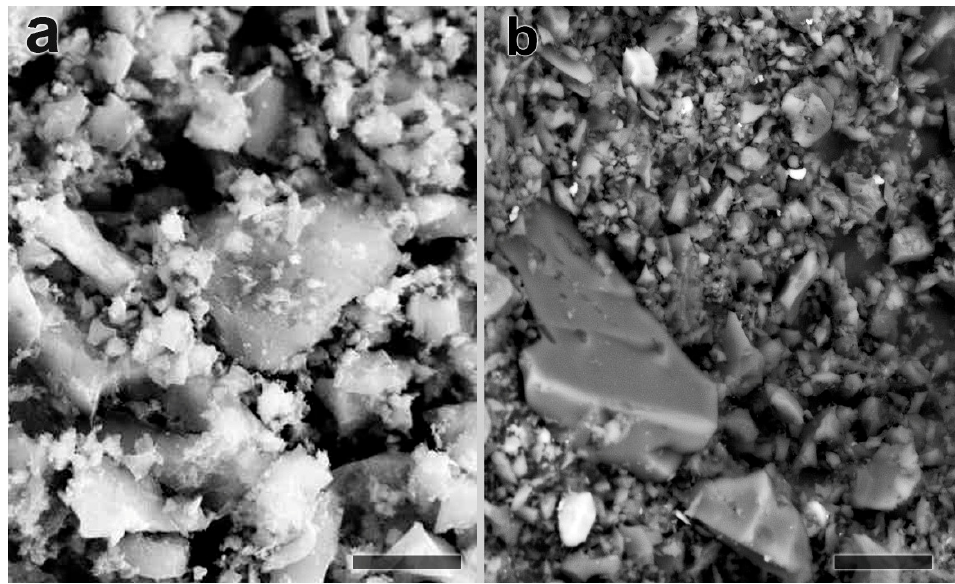
Figure 1. Surface microstructure of biochar ( a ) and granular activated carbon ( b ).